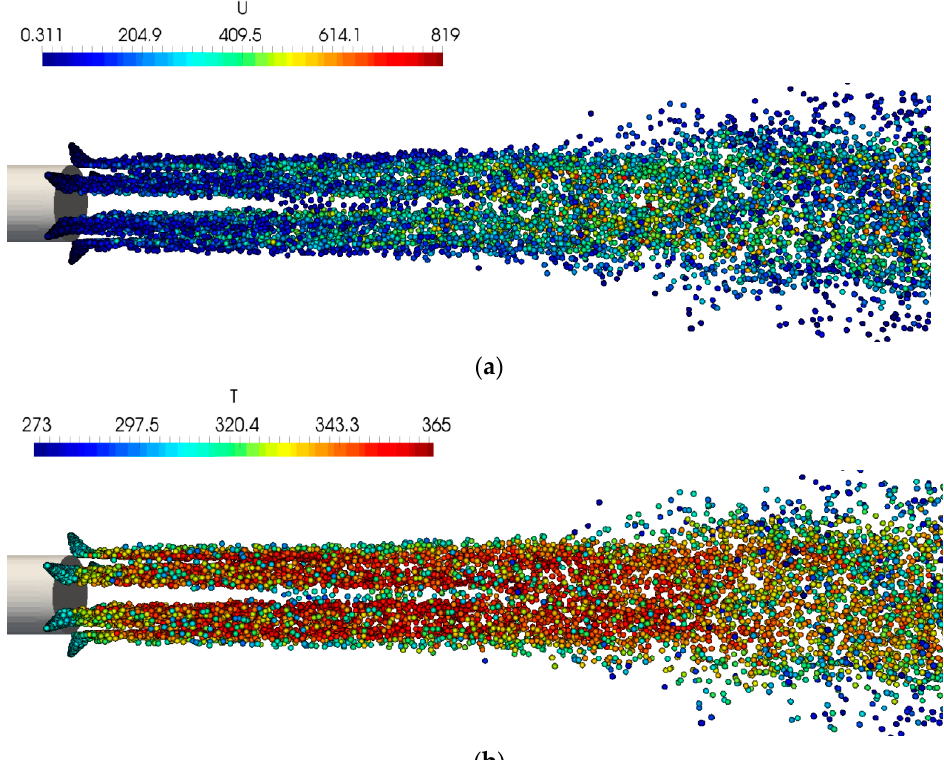
Figure 6. Mean velocity field: ( a ) normal jet; ( b ) with water injections.